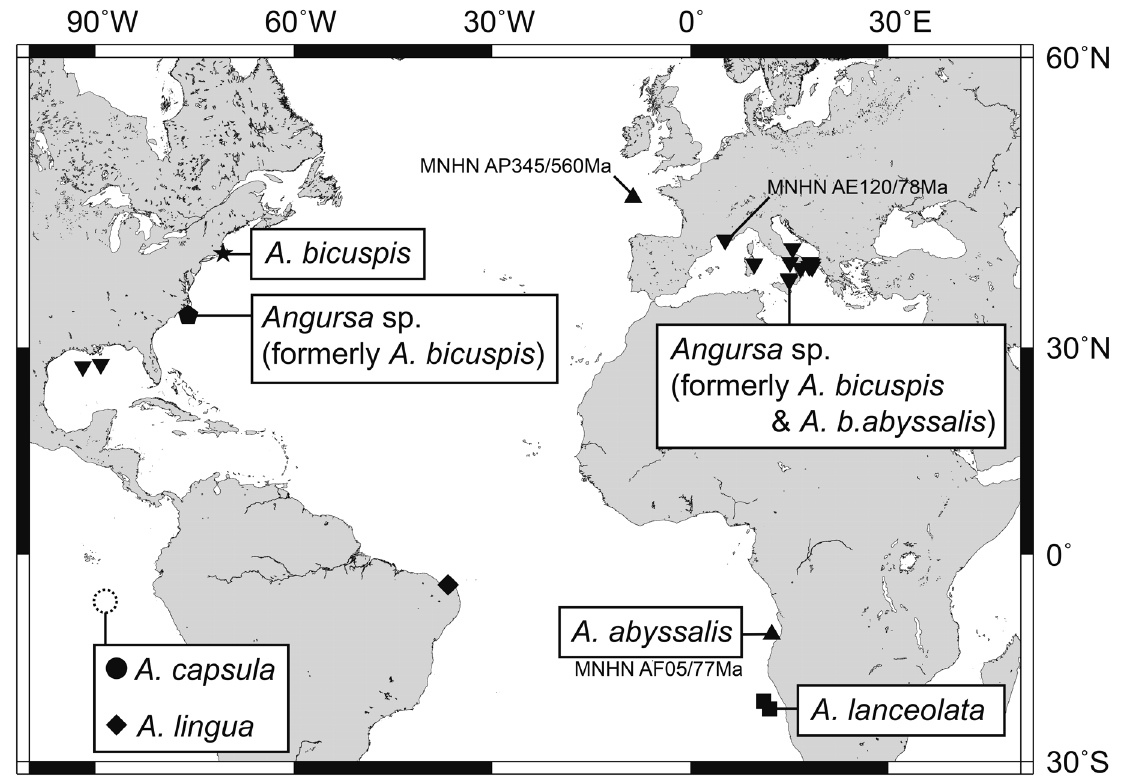
Fig. 8. Records of Angursa abyssalis Renaud-Mornant, 1981, A. bicuspis Pollock, 1979, and some